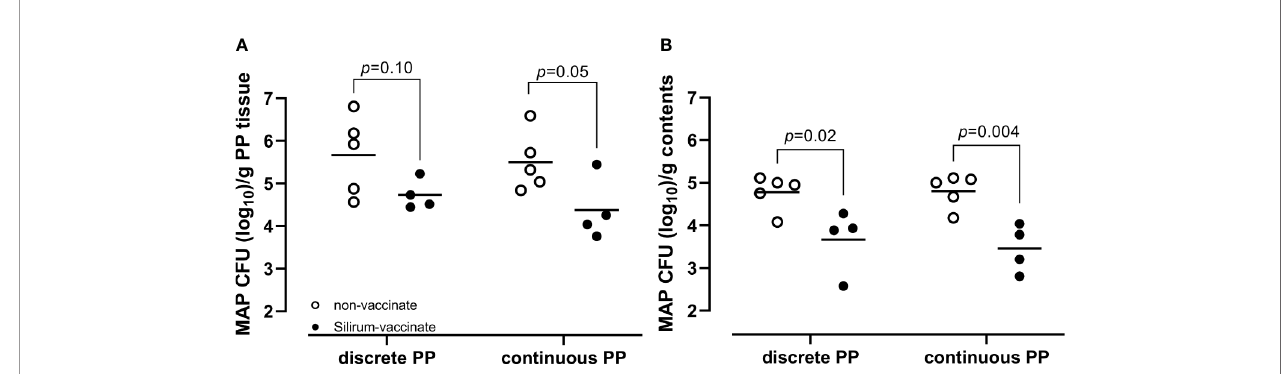
FIGURE 4 | Mycobacterium avium ssp. paratuberculosis (MAP) bacterial burden in intestinal tissue and luminal contents. (A) MAP recovery from discrete and continuous PP tissue from non-vaccinates (n=5) and Silirum vaccinates (n=4) at 28 days post-infection. (B) MAP recovery from the luminal contents of mid-jejunal segments containing a discrete PP and terminal jejunal segments containing a continuous PP from non-vaccinates (n=5) and Silirum vaccinates (n=4) at 28 days post-infection. Data presented are CFU counts from individual animals and the horizontal bar represents the mean value for each group. p values determined using a Student ’ s t-test.